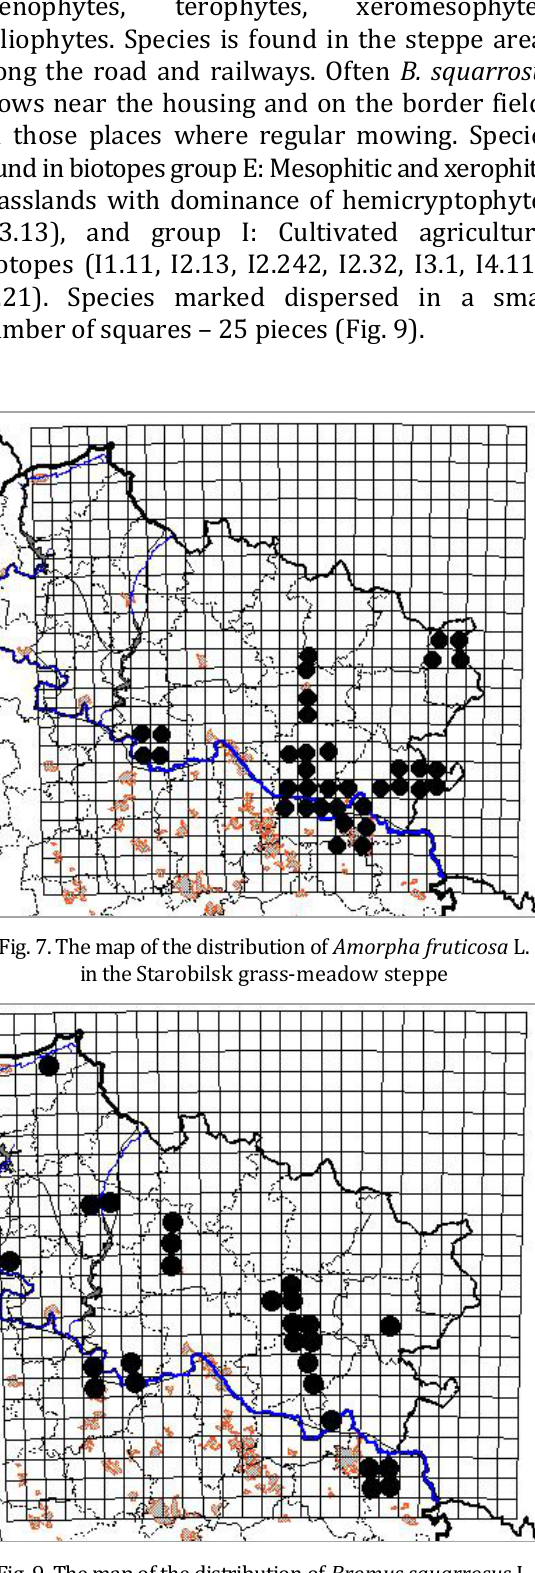
Fig. 9. The map of the distribution of Bromus squarrosus L. in the Starobilsk grass-meadow